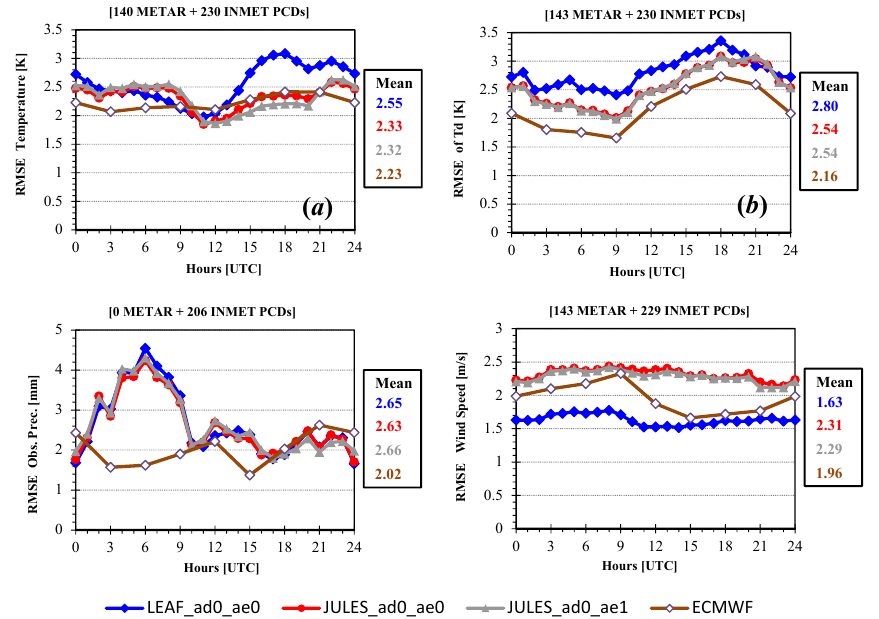
Fig. 6. Similar to Fig. 4, but for the dry season (September 2010): (a) air temperature at 2m; (b) dew point temperature at 2m; (c) six- hour accumulated precipitation and (d) wind speed at 10m. The gray line is from the JULES-CCATT-BRAMS model with non-monotonic advection (ad0), using JULES surface model and considering the presence of aerosol (ae1).